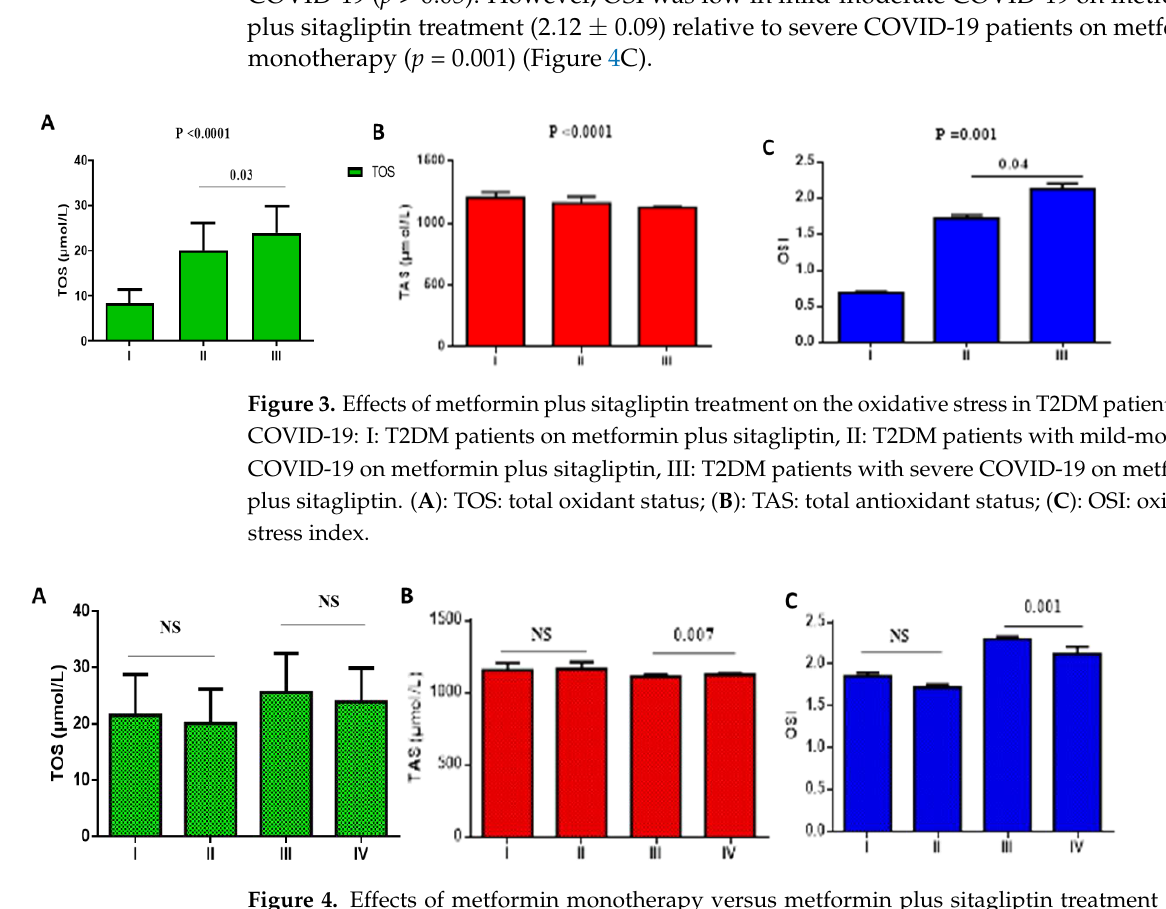
Figure 4. Effects of metformin monotherapy versus metformin plus sitagliptin treatment on the oxidative stress in T2DM patients with COVID-19: I: T2DM patients on metformin with mild-moderate COVID-19, II: T2DM patients on metformin plus sitagliptin with mild-moderate COVID-19, III: T2DM patients with severe COVID-19 on metformin monotherapy, IV: T2DM patients with severe COVID-19 on metformin plus sitagliptin. ( A ): TOS: total oxidant status; ( B ): TAS: total antioxidant status; ( C ): OSI: oxidative stress index. NS: not significant.